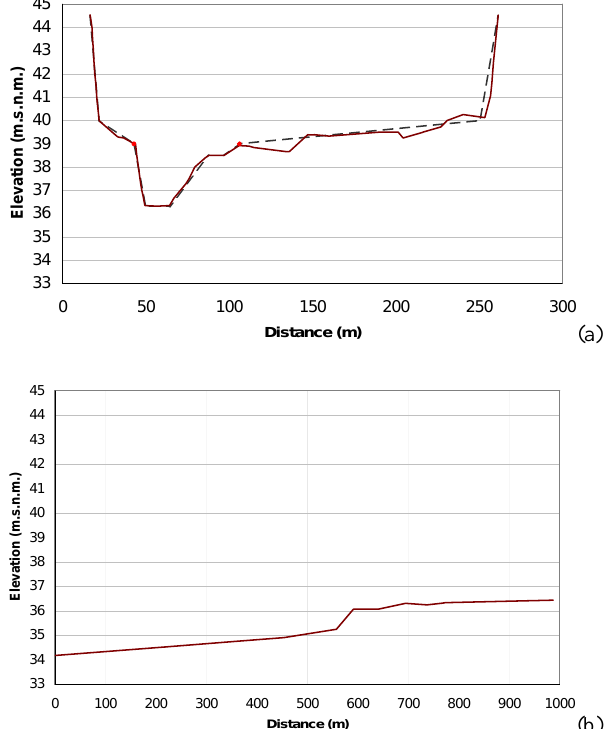
Fig. 2. 1-D model Geometry of the cross section at RS 768 of the HEC RAS model, with the simplified cross section for the uniform flow model showed with dashed line (a) and river reach ground pro- file for 1-D HEC-RAS model (b)